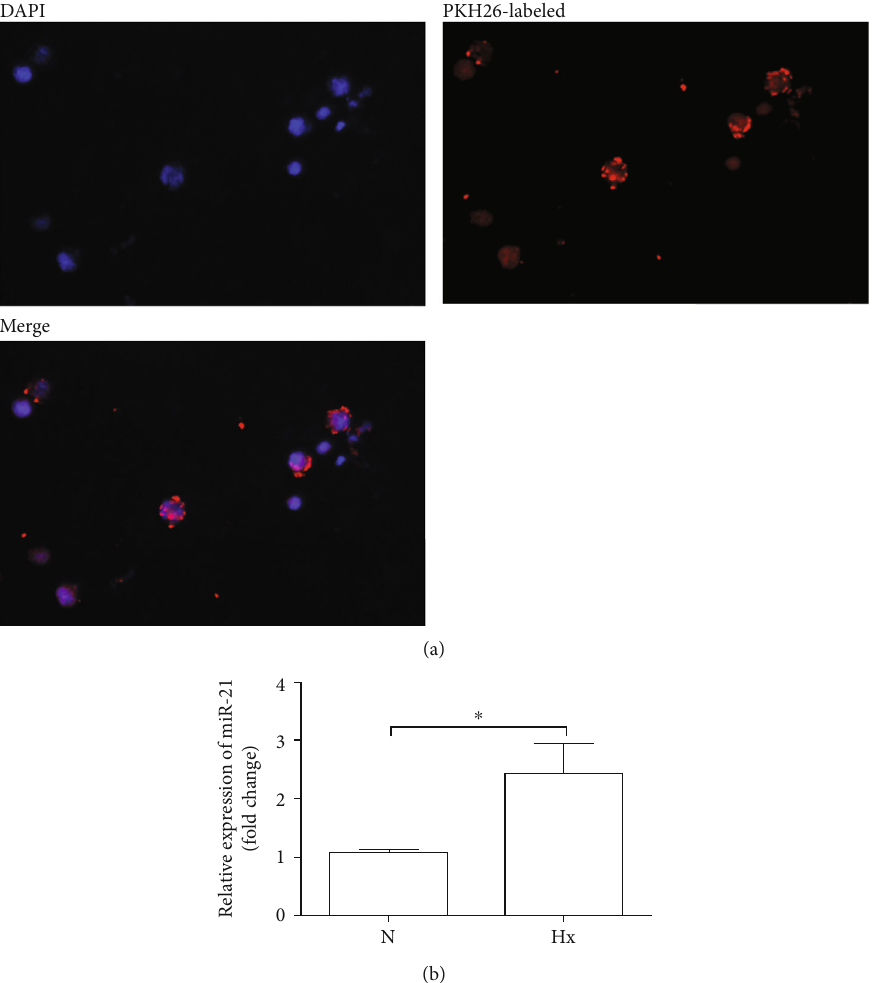
Figure 3: Hypoxic KEL cell-derived exosomes horizontally transferred miRNA-21 to the THP-1 cells. THP-1 cells were treated with exosomes labeled with PKH26 for 12 h, and after that, exosomes were washed o ff and media replaced. Nuclei were stained with DAPI. miRNA-21 levels were identi fi ed in THP-1 cells using RT-PCR. U6 was used to normalize the Ct values between the samples. (a) Representative fl uorescence microscopy of THP-1 after incubation with exosomes. (b) Statistical assay of the expression level of miRNA- 21 in THP-1 after the uptake of exosomes. N: normoxia; Hx: